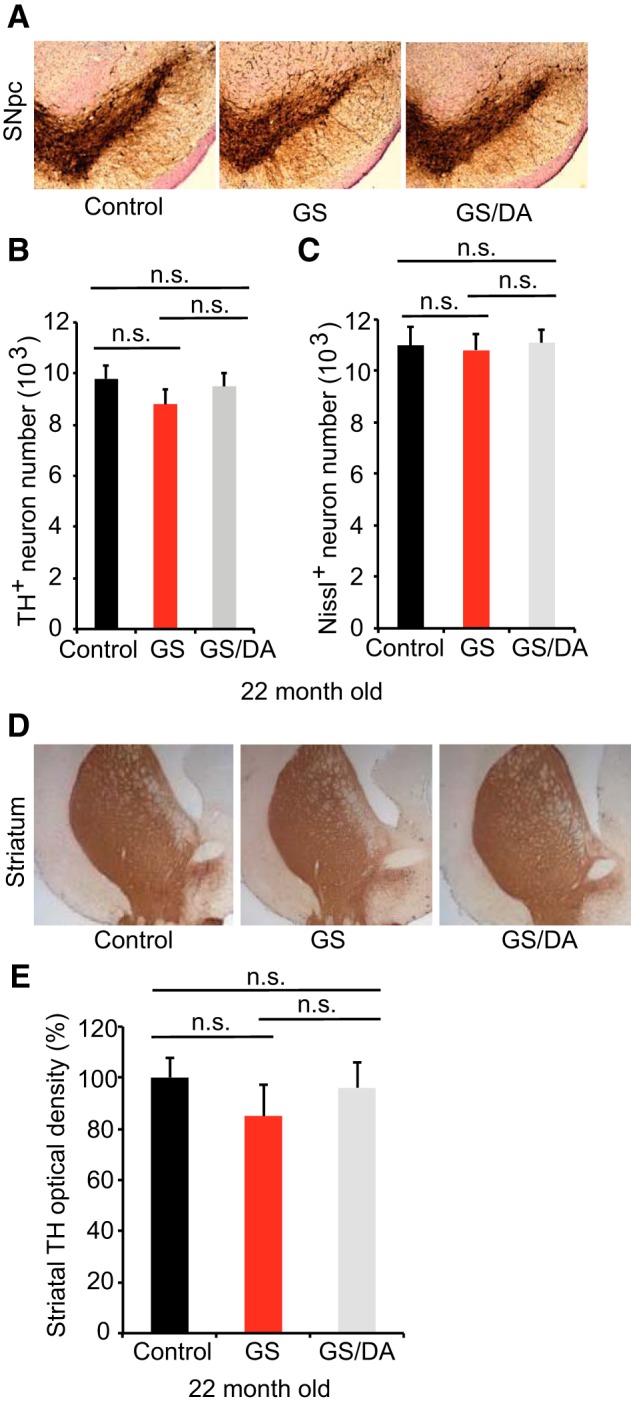
Characterization of the nigrostriatal pathway of LRRK2 conditional transgenic mice. A, Representative TH immunohistochemistry of the midbrain coronal sections of 22-month-old LRRK2 GS and GSDA transgenic and age-matched littermate controls. B, C, Stereological assessment of TH-positive (B) and Nissl-positive (C) neurons in the SNpc (control, n = 9; GS, n = 9; GS/DA, n = 9). Data are the mean number of cells per region ± SEM, n = 9 mice per group. Statistical significance was determined by two-tailed unpaired Student’s t test. D, Representative images of TH immunostaining of nerve terminals in the striatum of LRRK2 conditional transgenic mice at 22 months of age. E, Quantitation of TH immunostaining in the striatum using ImageJ software (NIH; control, n = 7; GS, n = 7; GS/DA, n = 7). Differences between groups were assessed by two-way ANOVA. Bars represent the mean ± SEM (n ≥ 5 animals/genotype). n.s., Nonsignificant.